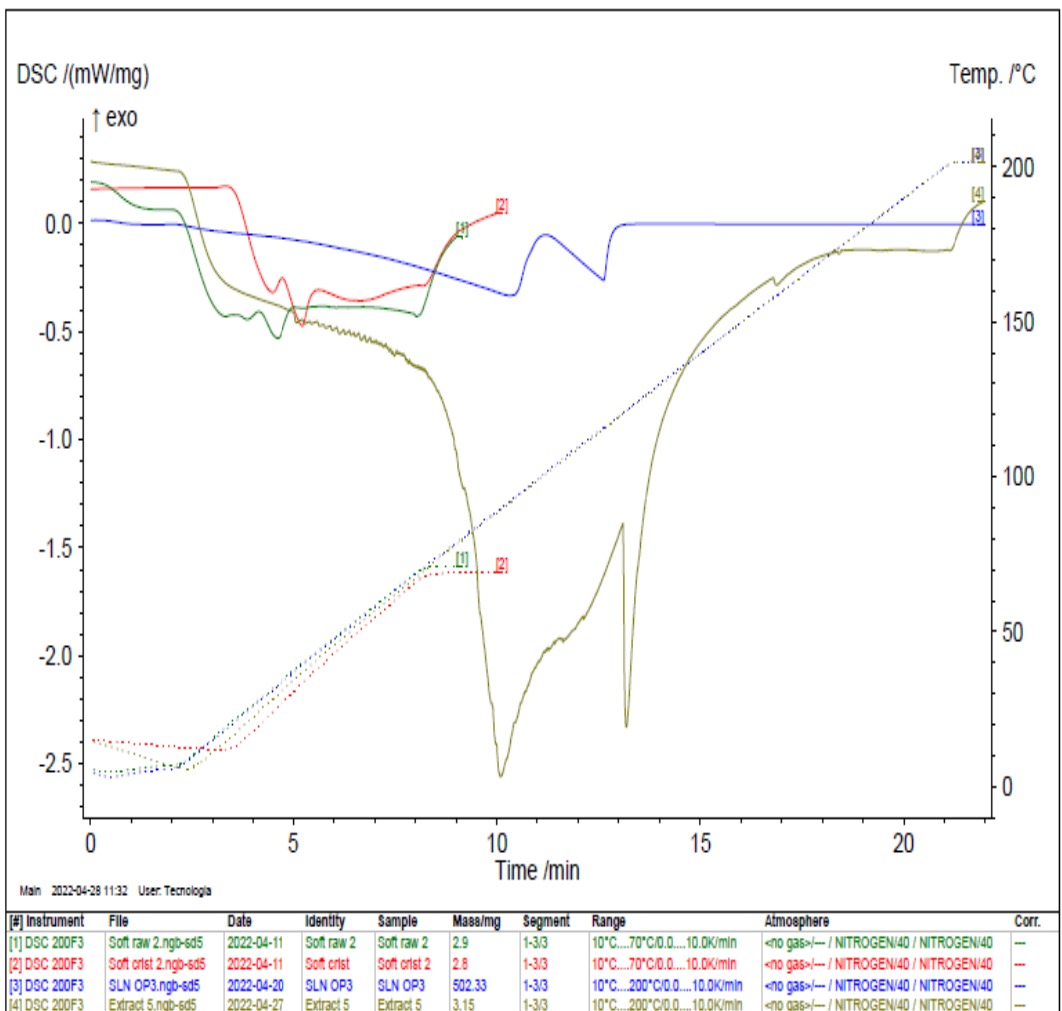
Figure 8. DSC analysis of the optimal LN (blue), N. gaditana extract (gray), raw SOFTISAN ® 649 (green), and crystallized SOFTISAN ® 649 (red).